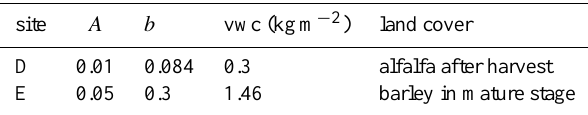
Table 3. Vegetation parameters used in the water cloud